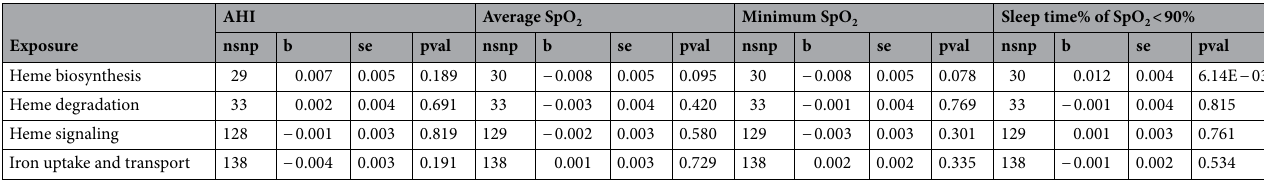
Table 1. Discovery two sample MR of canonical iron/heme related pathways (reactome) on OSA traits using Inverse Weighted Variance